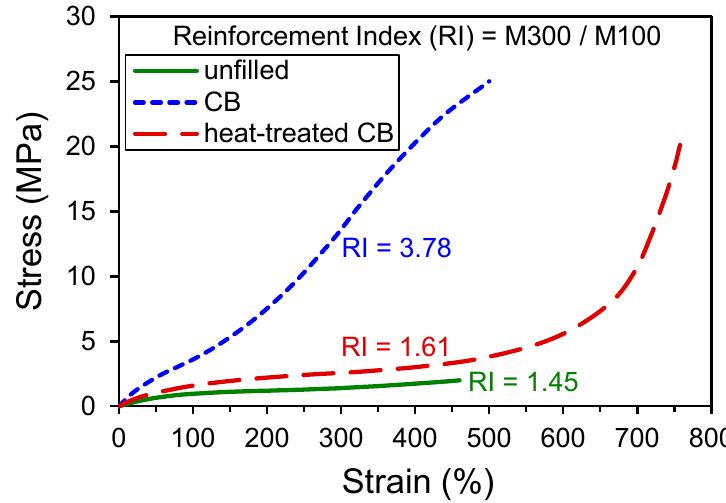
Figure 2. Tensile stress–strain results for non-crystallizing rubber vulcanizates including unfilled rubber and rubber compounds filled with CB and heat-treated CB. Data replotted from Medalia and Kraus [6].